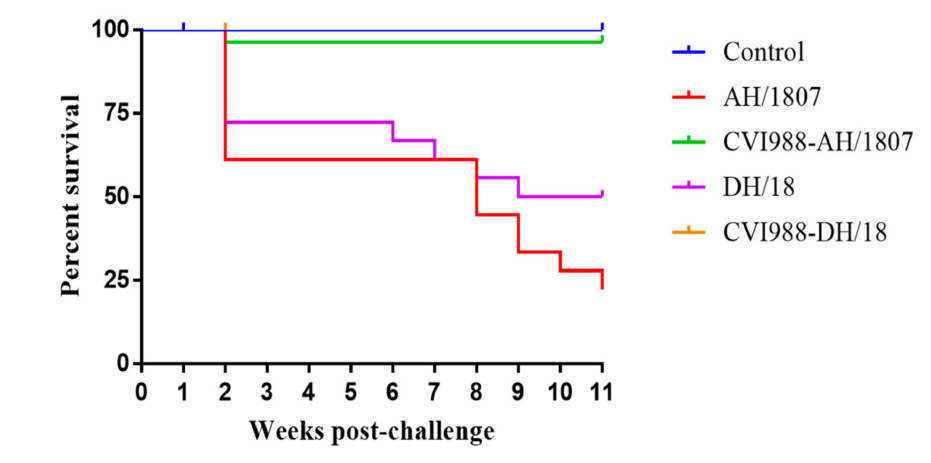
Figure 3. Chicken survival curves for each treatment group. The survival patterns in the AH/1807- challenged and DH/18-challenged groups exhibited effects of infection with two strains. It exhibited significant differences ( p < 0.05) by log-rank (Mantel–Cox)